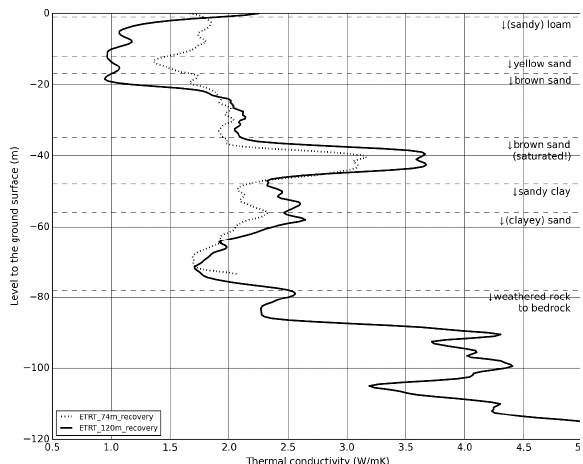
Figure 16. Comparison of the thermal conductivity resulting from enhanced TRTs for a 74-m-deep and a 120-m-deep borehole in Limelette (Belgium), separated by about 6 m. Based on data from the Smart Geotherm project funded by the agency Flanders Innovation and Entrepreneurship.